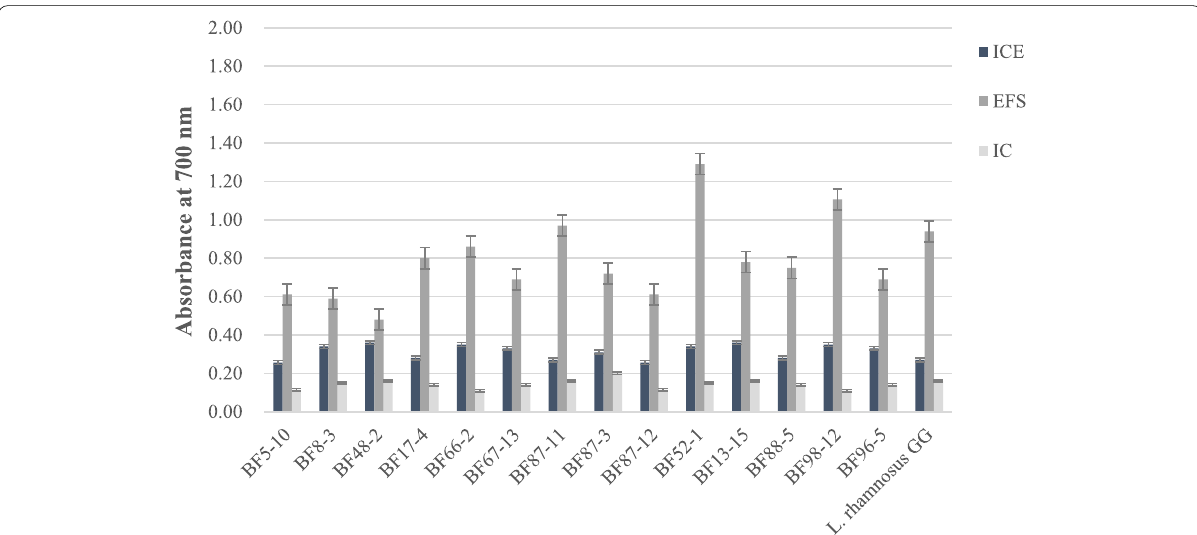
Fig. 7 The total reducing power of the Bifidobacterium strains’ intracellular cell extract (ICE), extracellular fermentation supernatant (EFS), and intact cells (IC) of the strains. (Error bars indicate standard deviation from three independent